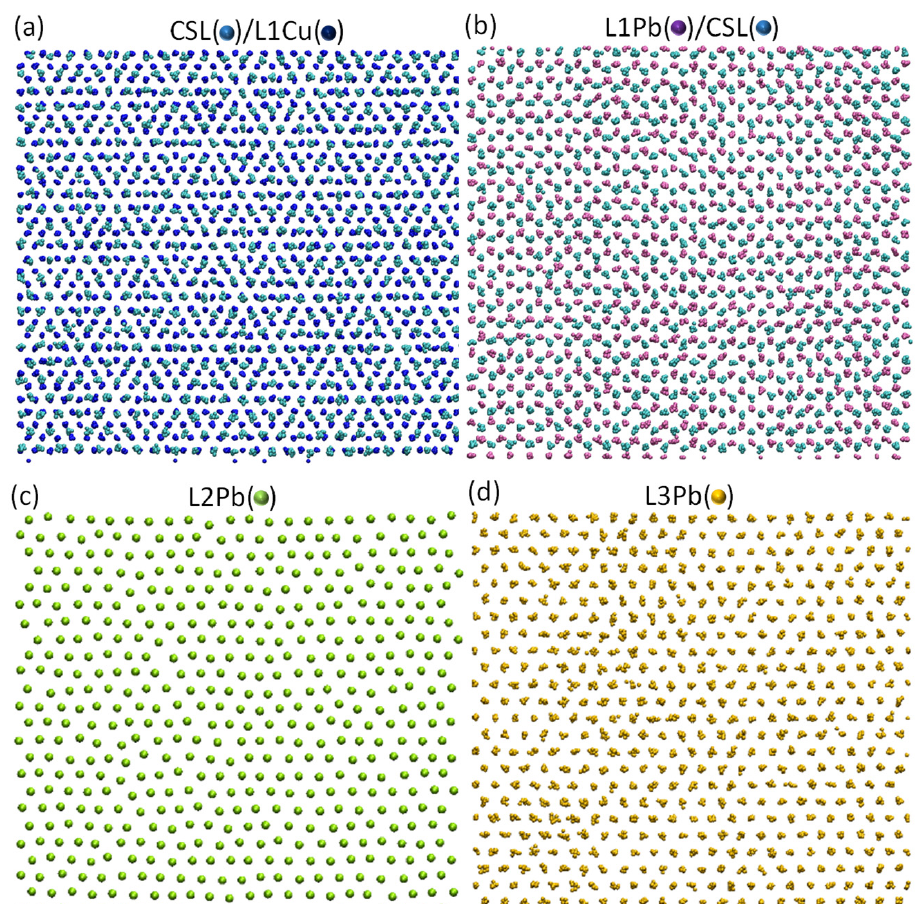
Figure 8. Atomic arrangements in the Pb( l )/Cu( s ) system at T n = 594 K at the end of nucleation ( t = 190 ps); ( a ) Time-averaged atomic positions of CSL Pb/L1Cu showing coincidence site lattice (CSL) as a mechanism to accommodate the major lattice misfit; ( b ) time-averaged atomic positions of L2Pb/CSL Pb showing the epitaxial relationship between L1Pb and CSL Pb; ( c ) a snapshot of L2Pb showing the existence of vacancies (as quantified in Figure 9a) as a mechanism to accommodate the residual lattice misfit; and ( d ) time-averaged atomic positions of L3Pb showing a perfect plane of (111) Pb as a 2D nucleus that demarcates the end of nucleation and the start of crystal growth. Figure 8d presents the time-averaged atomic positions of L3Pb at t = 190 ps. Detailed analysis confirmed that L3Pb contained only a small fraction of vacancies that was compa- rable with equilibrium vacancy concentration, but no other defects were found. In addition, L3Pb (Figure 8d) has a hexagonal atomic arrangement and an average atomic spacing of d a = 3.53 Å, which matches well those of (111) plane of the bulk solid Pb. Therefore, L3Pb can be taken as a 2D nucleus, which marks the end of heterogeneous nucleation and the onset of crystal